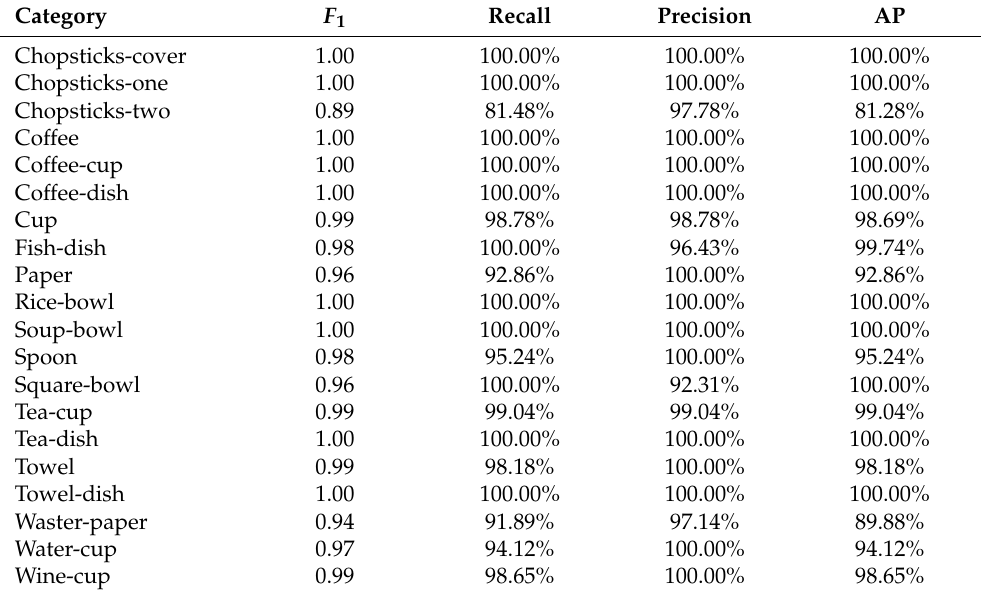
Table 2. Test results of different dish classes in